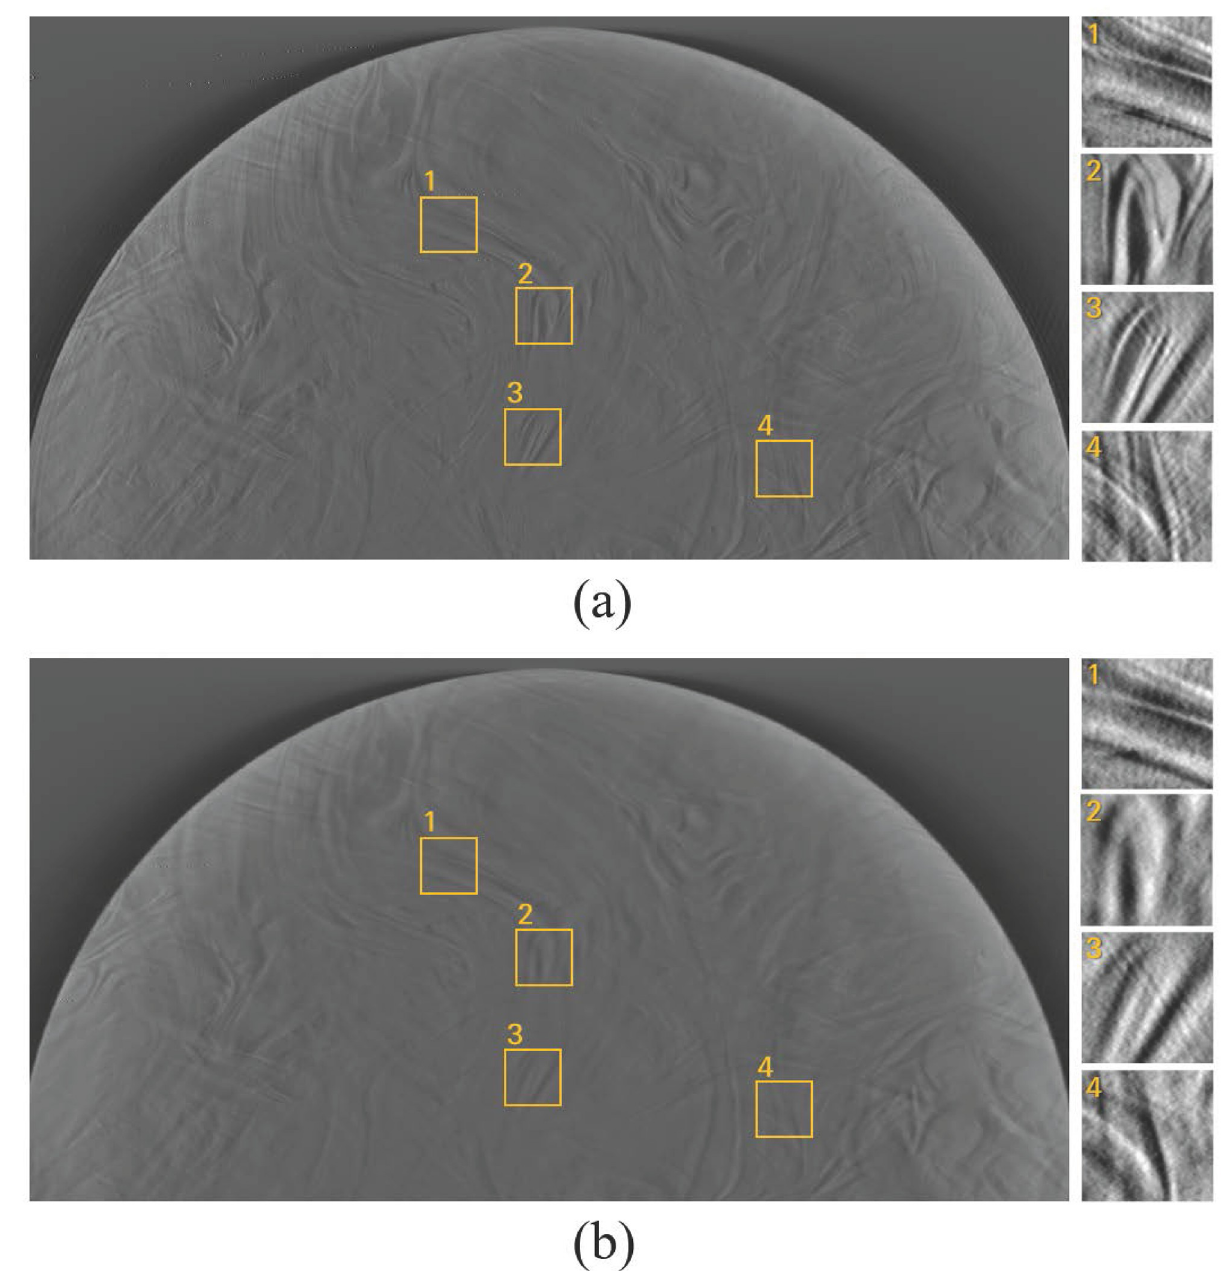
Fig 6. Examples of reconstructed BR3D breast phantom without spherical signal. (a) is a reconstructed image using projection data in step-and- shoot mode, and (b) is the corresponding image using projection data in continuous mode. Four 100 × 100 images are cropped to show the detailed anatomical background (indicated by the yellow box). The display window is set by [min. max.] mm − 1 to visualize the background structures more